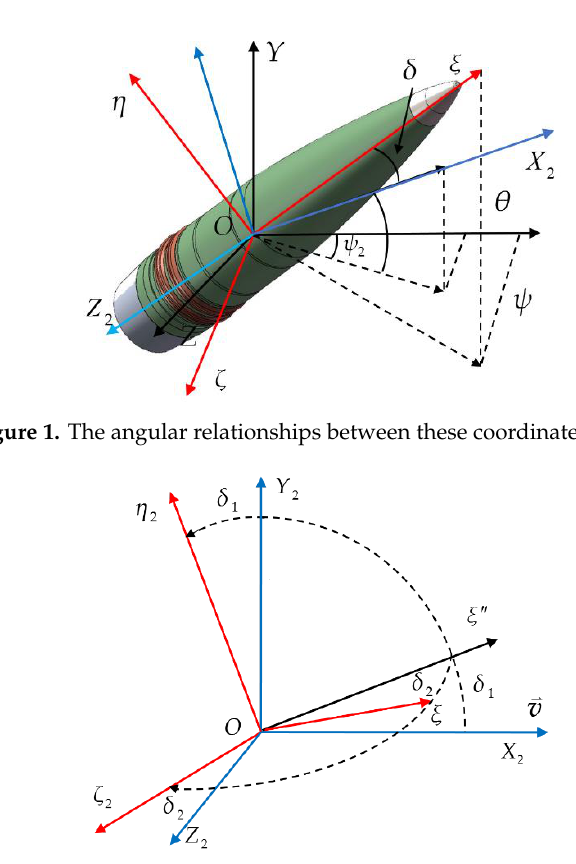
Figure 2. Coordinate system O − X 2 Y 2 Z 2 turns to Coordinate system O − ξη 2 ζ 2 .